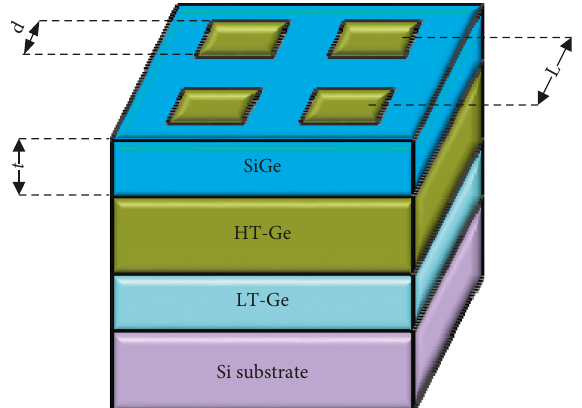
Figure 4: Structural diagram of the direct band gap Ge imple- mentation method compatible with the Si process.